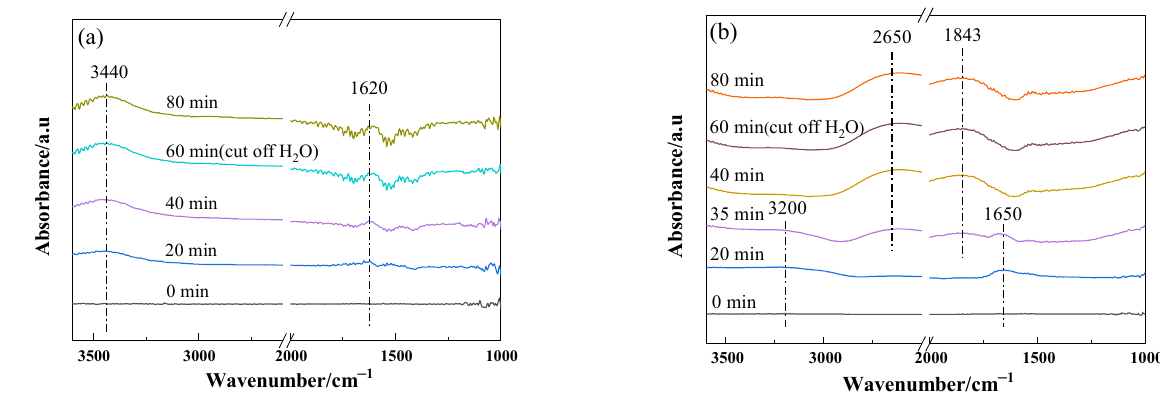
Figure 10. Changes in H 2 O-DRIFTS spectra of Pt/Keg-CeTi ( a ) and Pt/MoP-CeTi ( b ) with time. Conditions: [H 2 O] = 3 vol%, balance N 2 , total flow rate = 50 mL/min, at 250 ◦